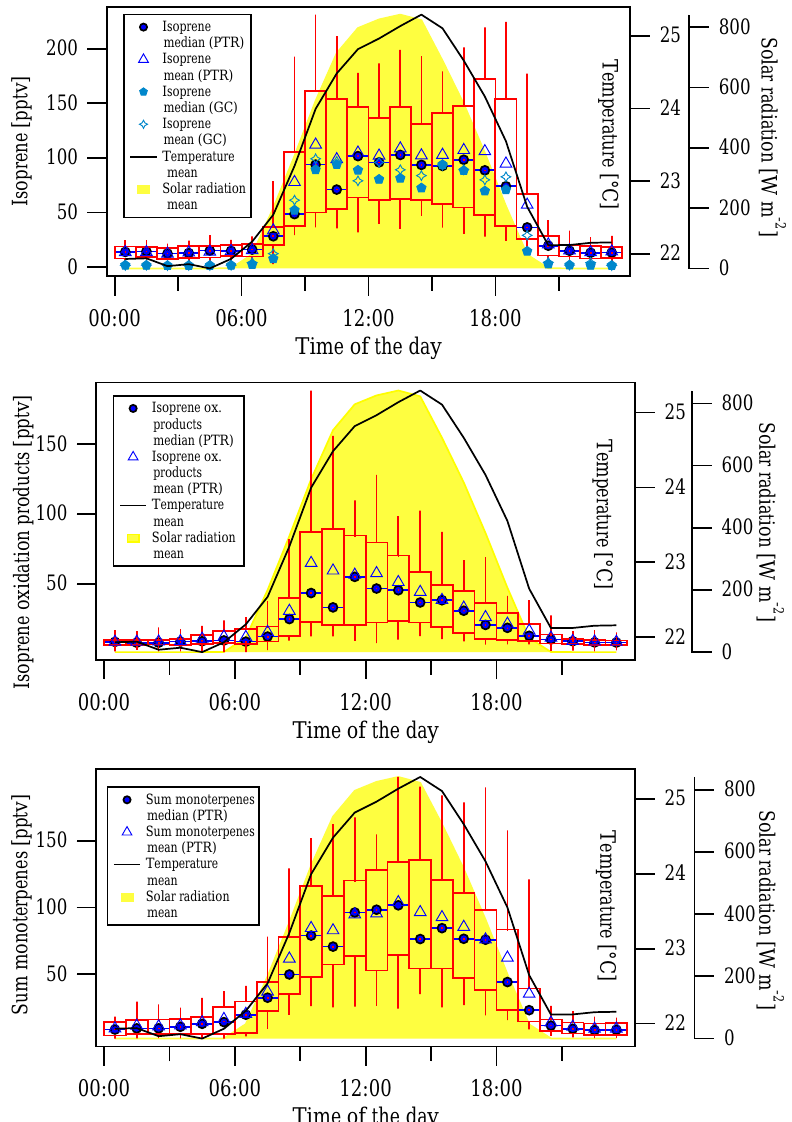
Figure 3. Box-and-whisker plots of isoprene, the oxidations products of isoprene and the sum of monoterpenes for the whole campaign with a 1h time resolution as measured by the PTR-TOF-MS. For comparison the median and mean isoprene values measured by GC-MS were added in the upper panel. To calculate the box plots, PTR-TOF-MS data with a time resolution of 10min and GC-MS data with a 45min time resolution (20min sampling time) were used. The contaminations in isoprene and the monoterpenes determined by comparing GC-MS and PTR-TOF-MS data were cut. The box contains 50% of the data, 25% of the data lie below the lower end of the box and 75% below the upper end. The whiskers present the 5–95% range of the